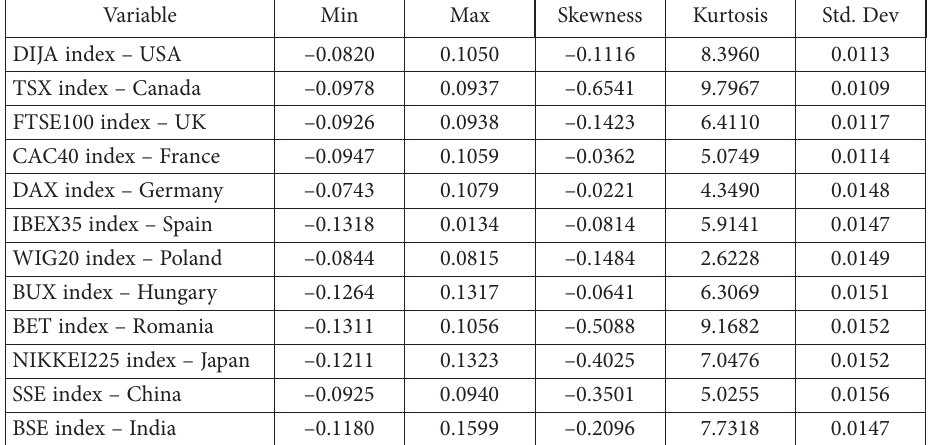
Table 1. Summary of statistics (source: author’s computation using first log difference of selected finan- cial data series from Jan 2000 to June 2018; *Mean and Median returns are merely zero for all selected markets)